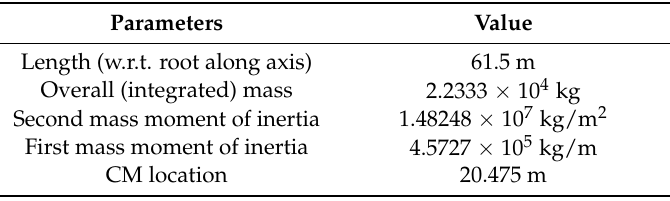
Table 2. Blade structural properties.